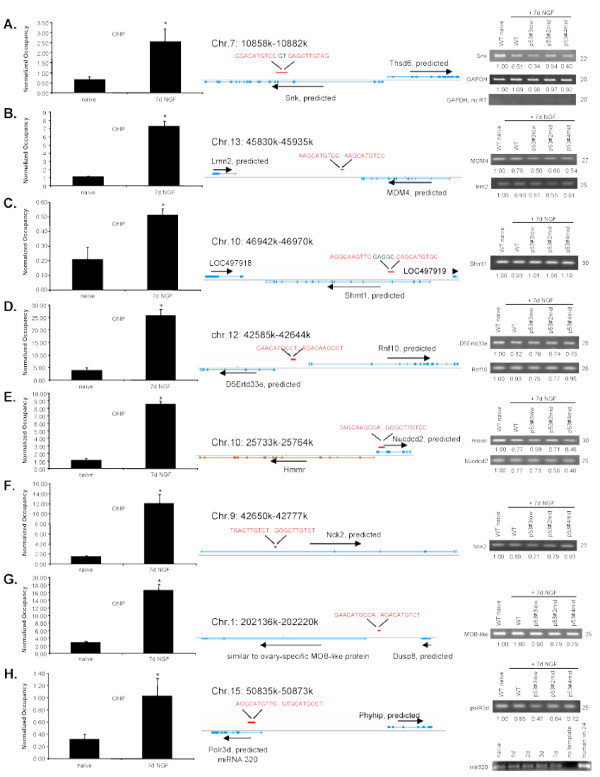
Targets with NGF-dependent increase in p53 occupancy, but where p53-dependent transactivation could not be clearly determined using anti-p53 shRNA expressing cell lines. Panels A-H show site-specific qPCR ChIP results on left with standard deviation, where significance at p ≤ 0.05 is designated by an asterisk (*). Note the p53-occupied sequences in Panels B, D and E lie between two genes so that were both examined for changes in expression. Display and analyses are as described in Figure 4 legend.